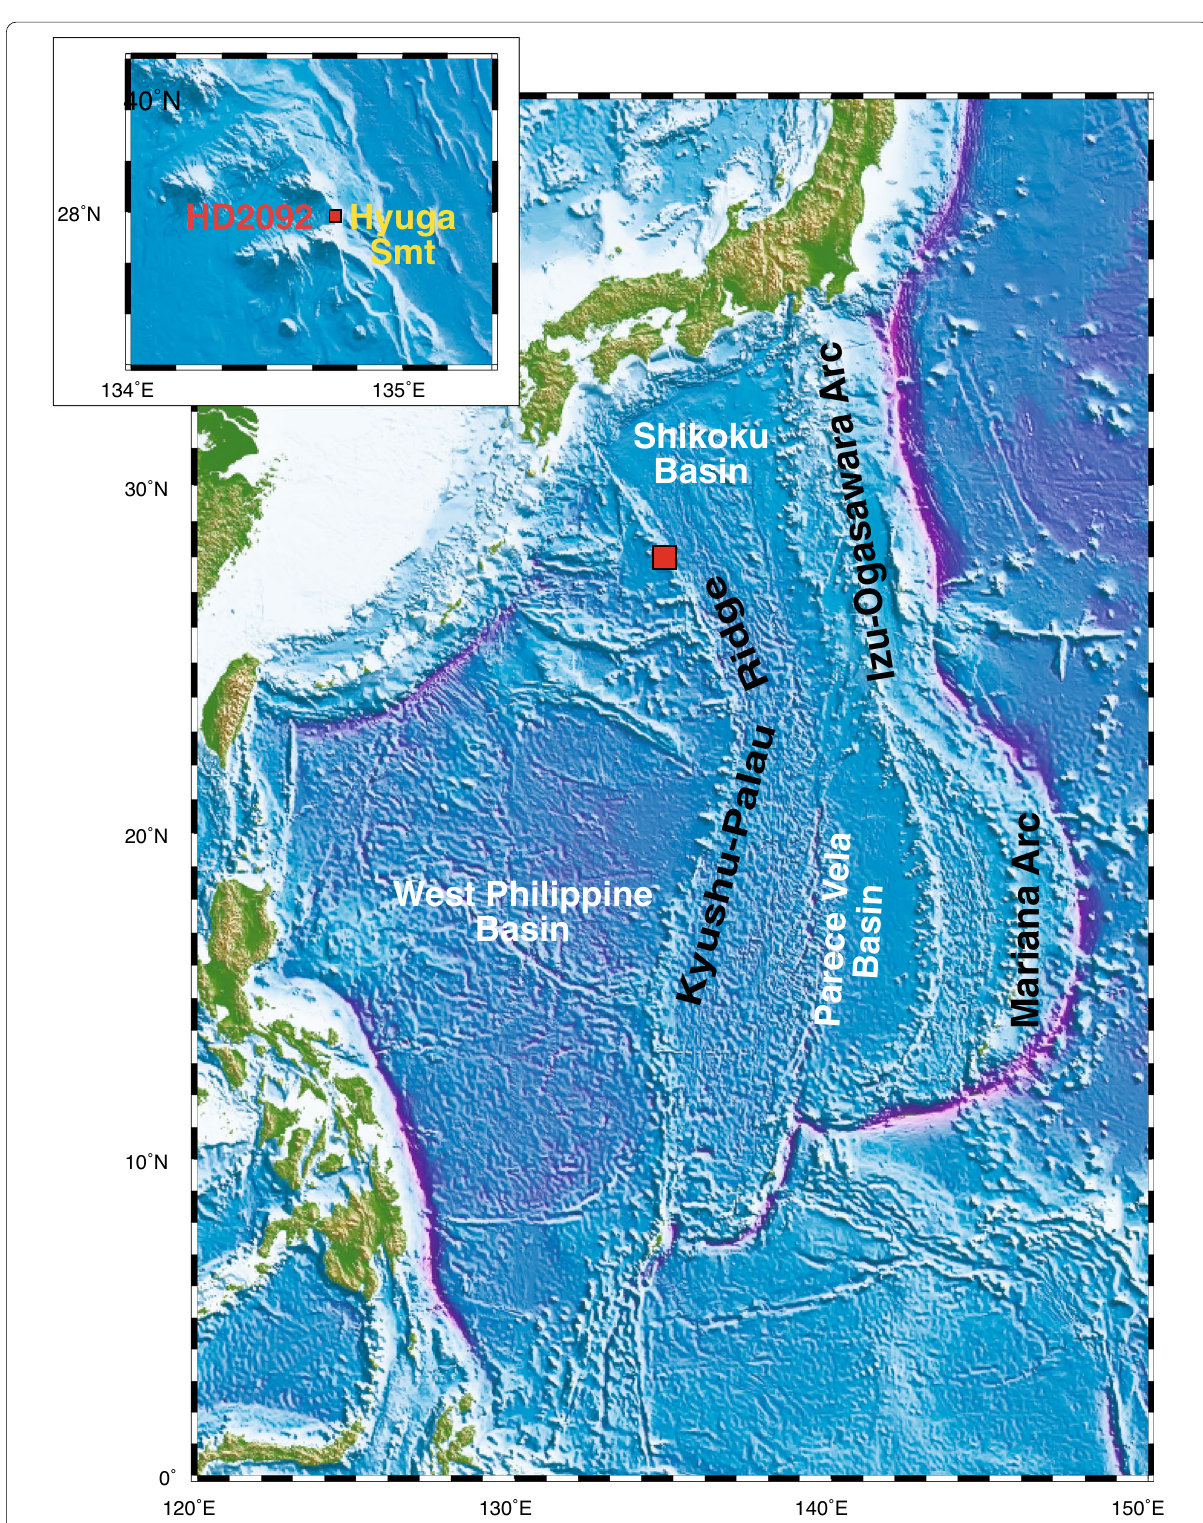
Fig. 1 Shaded relief map of the Philippine Sea plate and the location of the sampling site (red square). Around the Hyuga seamount is enlarged in the